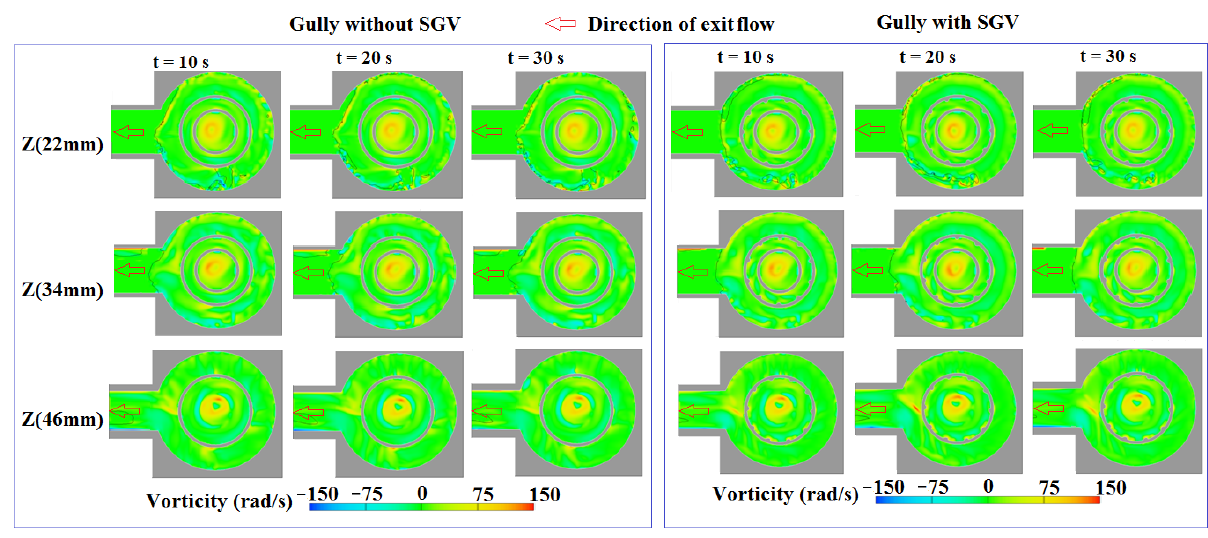
Figure 7. Distributions of instant vorticity for gullies with/without SGV over horizontal XY planes at Z = 22, 34, 46